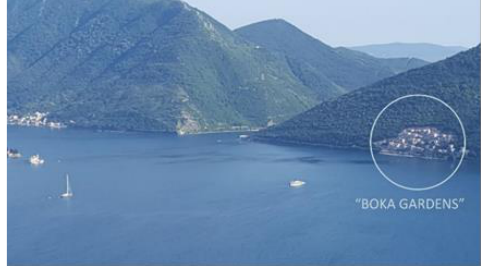
Figure 8. Tourist resort ‘Boka Gardens’ -location (Source: